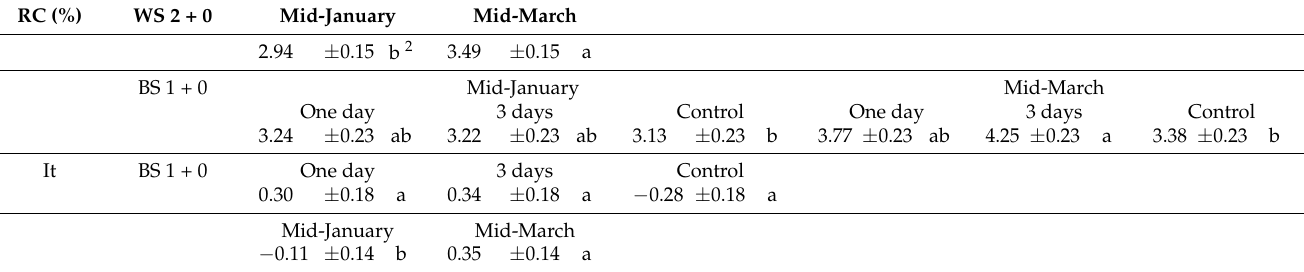
1 dln: degrees of freedom of numerator; dld: degrees of freedom of denominator. The relative electrical conductivity of the shoot of white spruce in mid-March was significantly higher than in mid-January (Table 5). On the other hand, in the case of black spruce, the relative electrical conductivity of the shoots of the control seedlings maintained at 4 ◦ C in the dark was significantly lower than the treatment of exposure for 3 days at 10 ◦ C for the mid-March sampling period (Table 5). The injury index of the shoots of black spruce in mid-March was significantly higher than that of January (Table 5). Table 5. Comparison 1 of adjusted means of the relative electrical conductivity (RC) and Index of Injury (It) of shoots of two-year-old white spruce and one-year-old black spruce seedlings between sampling date at the beginning (mid-January) and end of winter (mid-March) and three treatments (Control at 4 ◦ C in dark conditions, 1 day at 10 ◦ C and 3 days at 10 ◦ C under the natural photoperiod of the